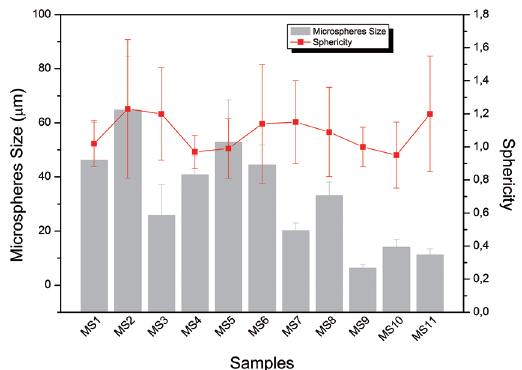
Figure 3: Mean Size and sphericity of the microspheres obtained by different processing conditions tested in the factorial design.